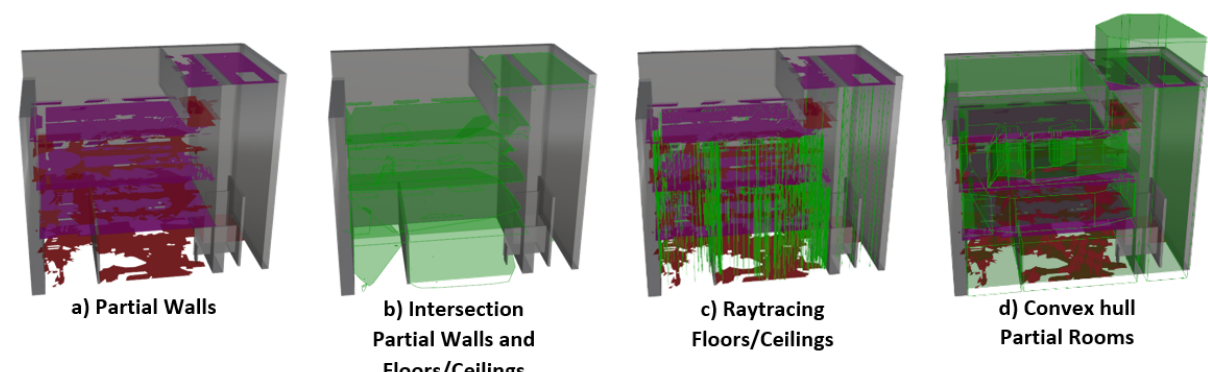
Figure 2: Overview workflow partial room reconstruction with partial walls in grey, floors in red and ceilings in purple: partial walls (a), adjusted floors/ceilings by intersection with partial walls (b), match between floors and overlaying ceilings trough ray-tracing (c) and convex hull of partial walls